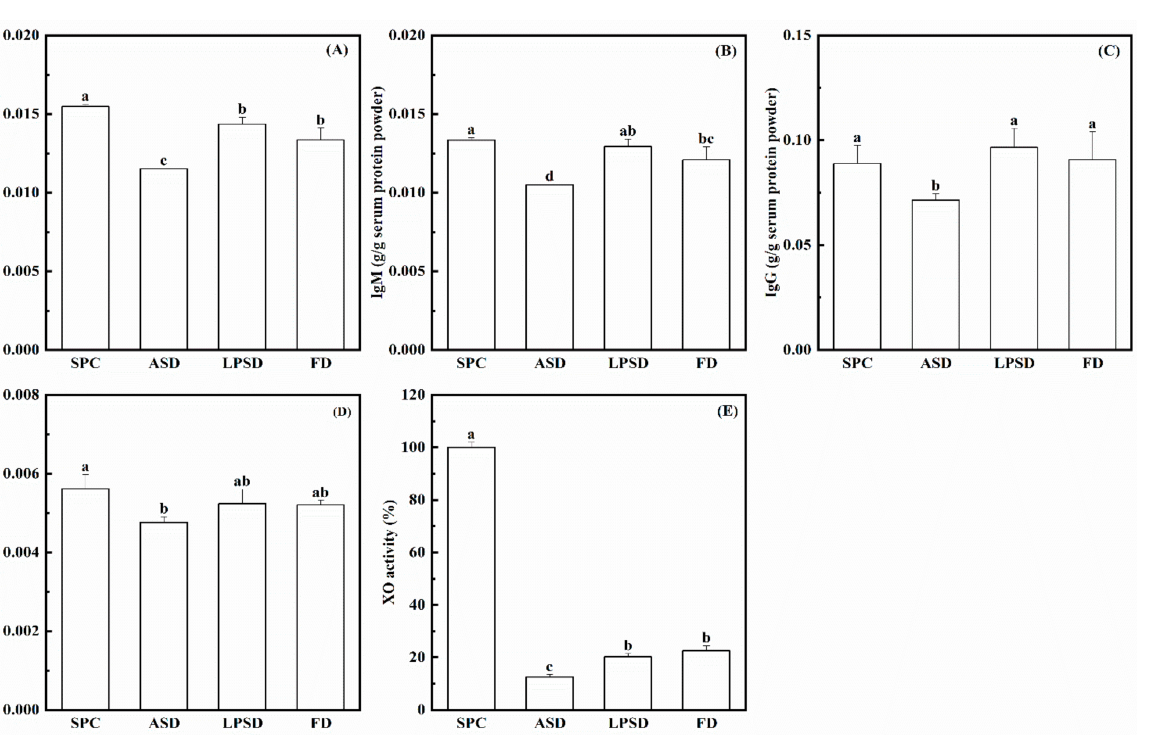
Figure 4. The contents of native ( A ) IgA, ( B ) IgM, ( C ) IgG, ( D ) LF and ( E ) bioactive XO in serum protein powder prepared by different drying methods. Different letters indicate significant difference ( p <